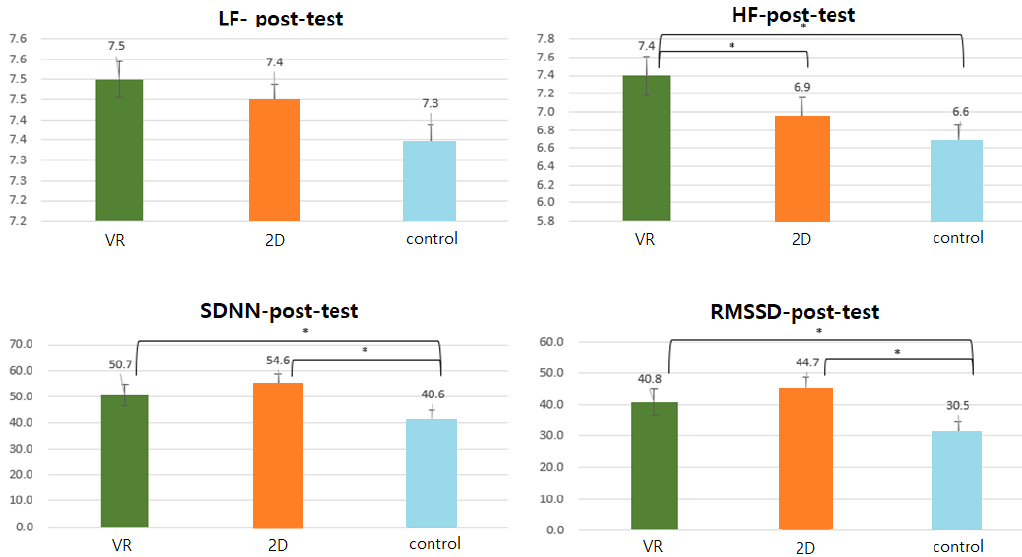
Figure 4. HRV results by group. *: p < 0.05